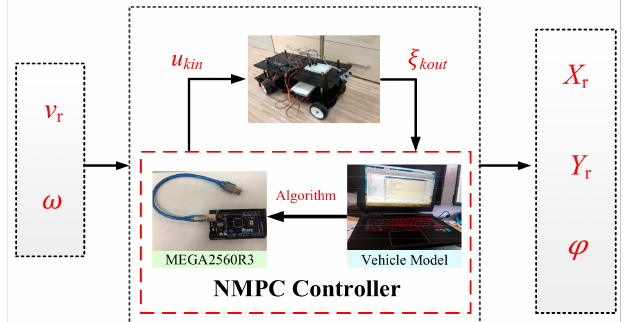
Figure 12. Schematic diagram of the experiment setup.